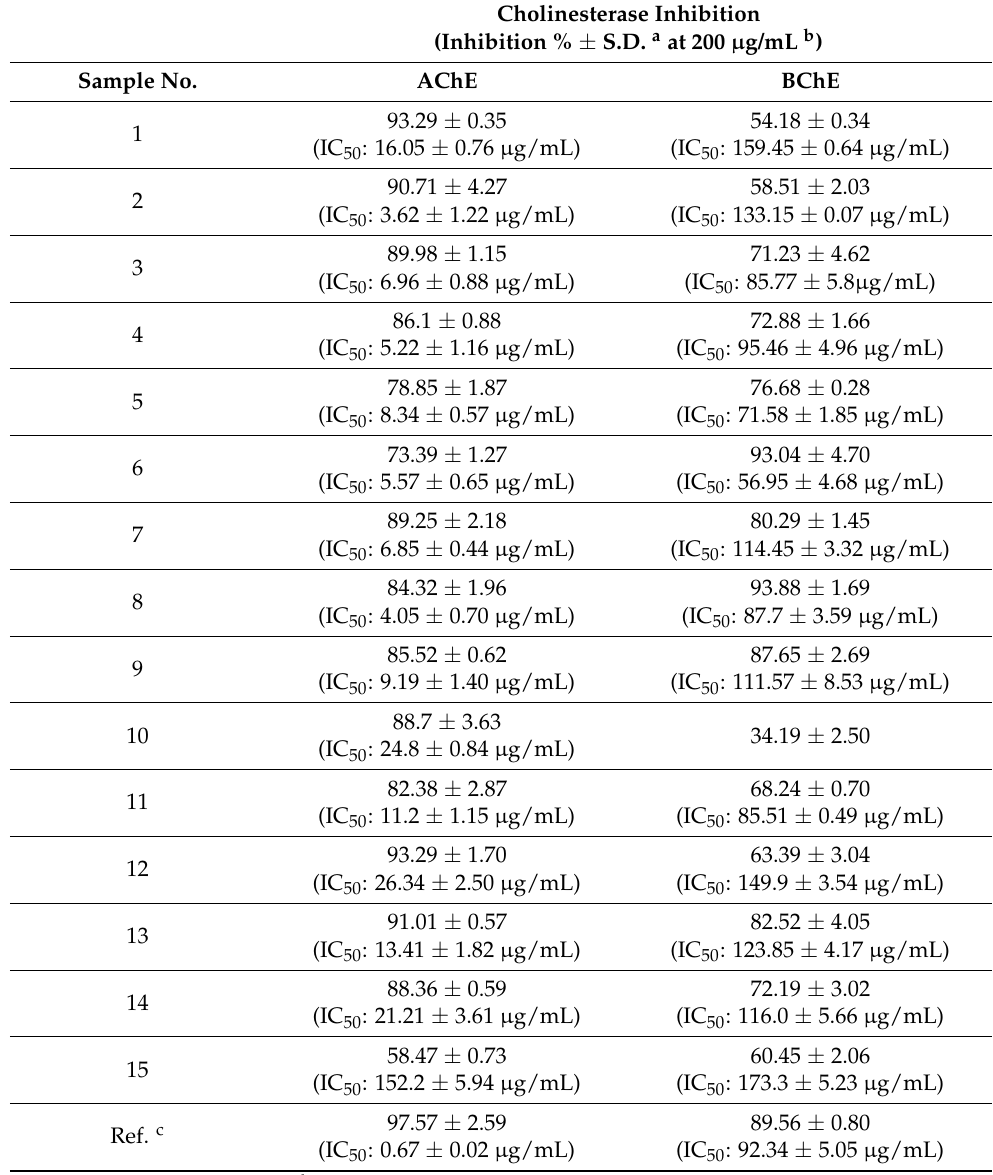
Table 6. AChE and BChE inhibition% and IC 50 values of EtOH extracts of R. rosea commercial samples. Cholinesterase Inhibition (Inhibition % ± S.D. a at 200 µ g/mL b ) Sample No.